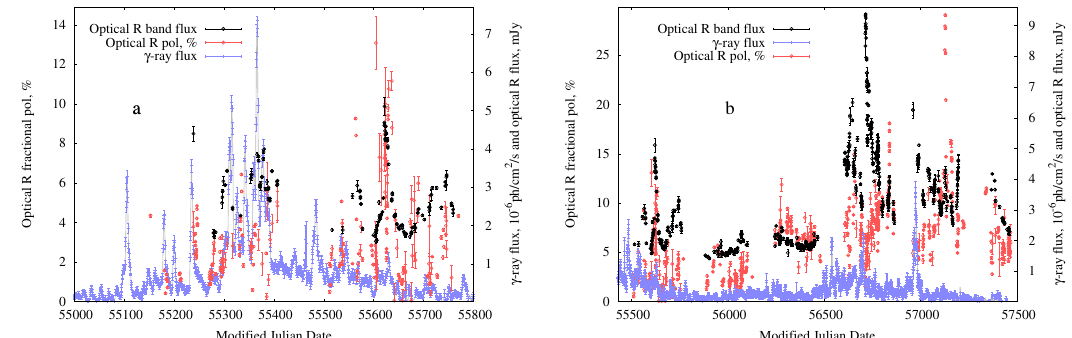
Figure 2. Light curves in γ rays, optical R band, and fractional polarization in optical R band for the periods ( a ) from MJD 55000 to MJD 55800 and ( b ) from MJD 55500 to MJD 57500.